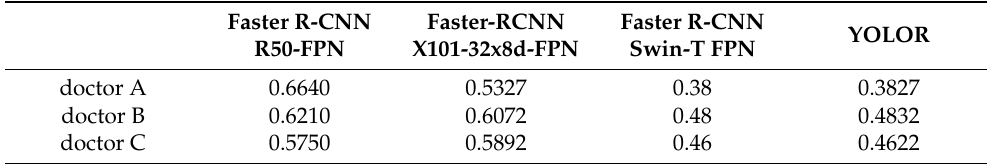
Table 3. DSC Results of Different Object Detection